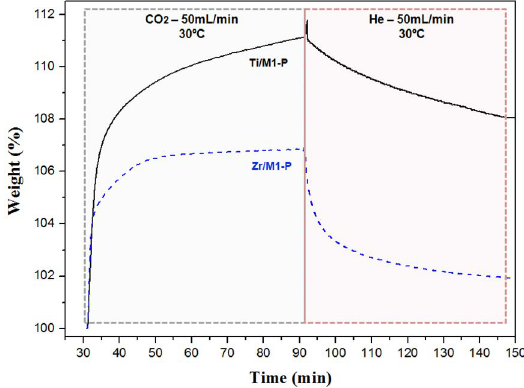
adsorption cycles of samples Ti/M1-P and Figure 14. CO 2